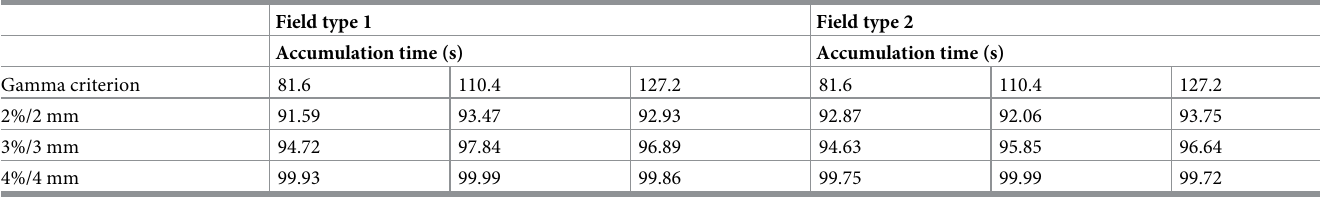
Table 3. Gamma analysis between the TRMLSD and EBT3 film for different gamma